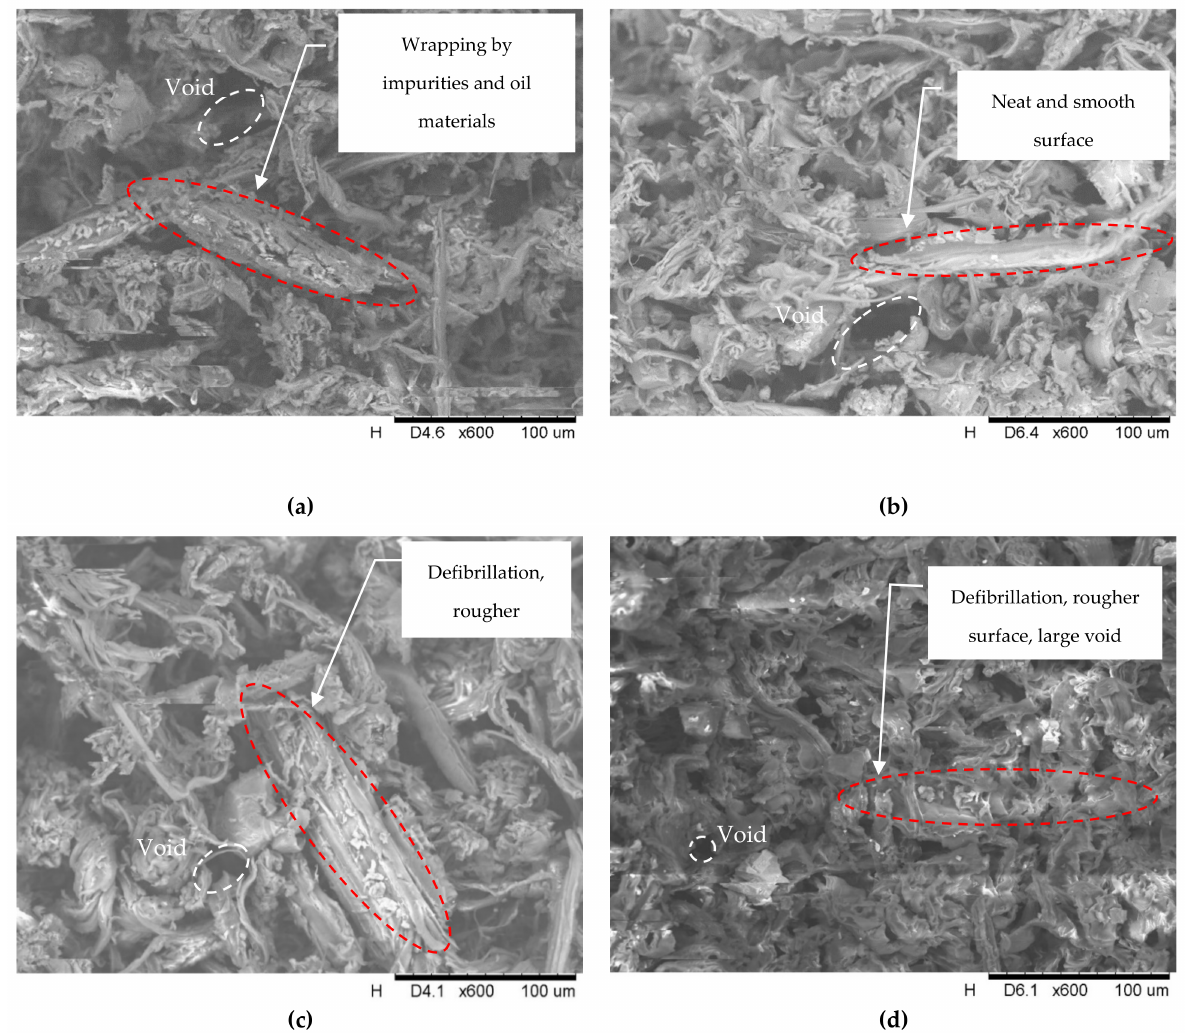
Figure 5. SEM analysis of BS ( a ) without treatment, ( b ) with aqueous treatment, ( c ) with hot aqueous treatment, ( d ) 10% concentration alkali